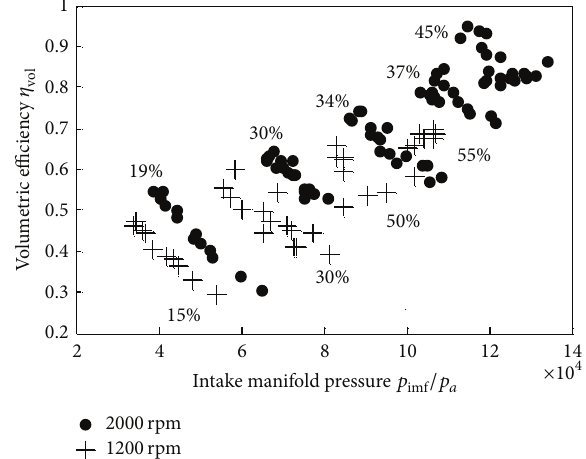
Figure 14: Volumetric efficiency for engine speeds 4500 rpm and 3000 rpm.